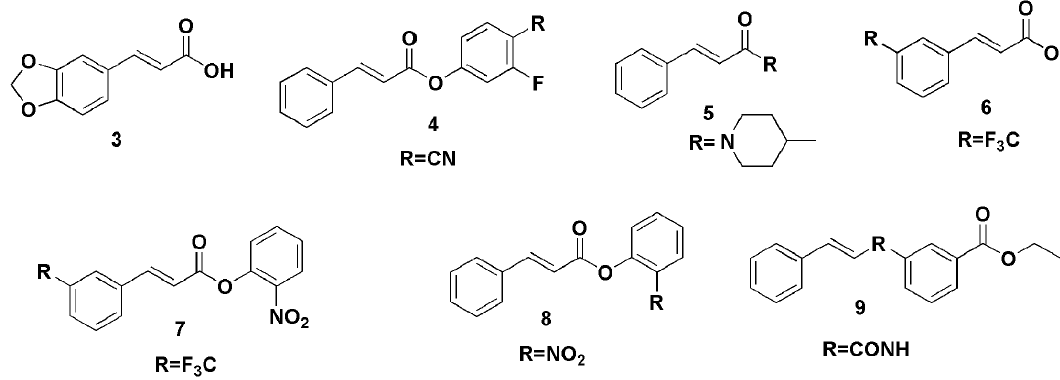
Figure 3. Chemical structures of cinnamic acid derivatives with antifungal activity ( 3 – 9 ) [22].